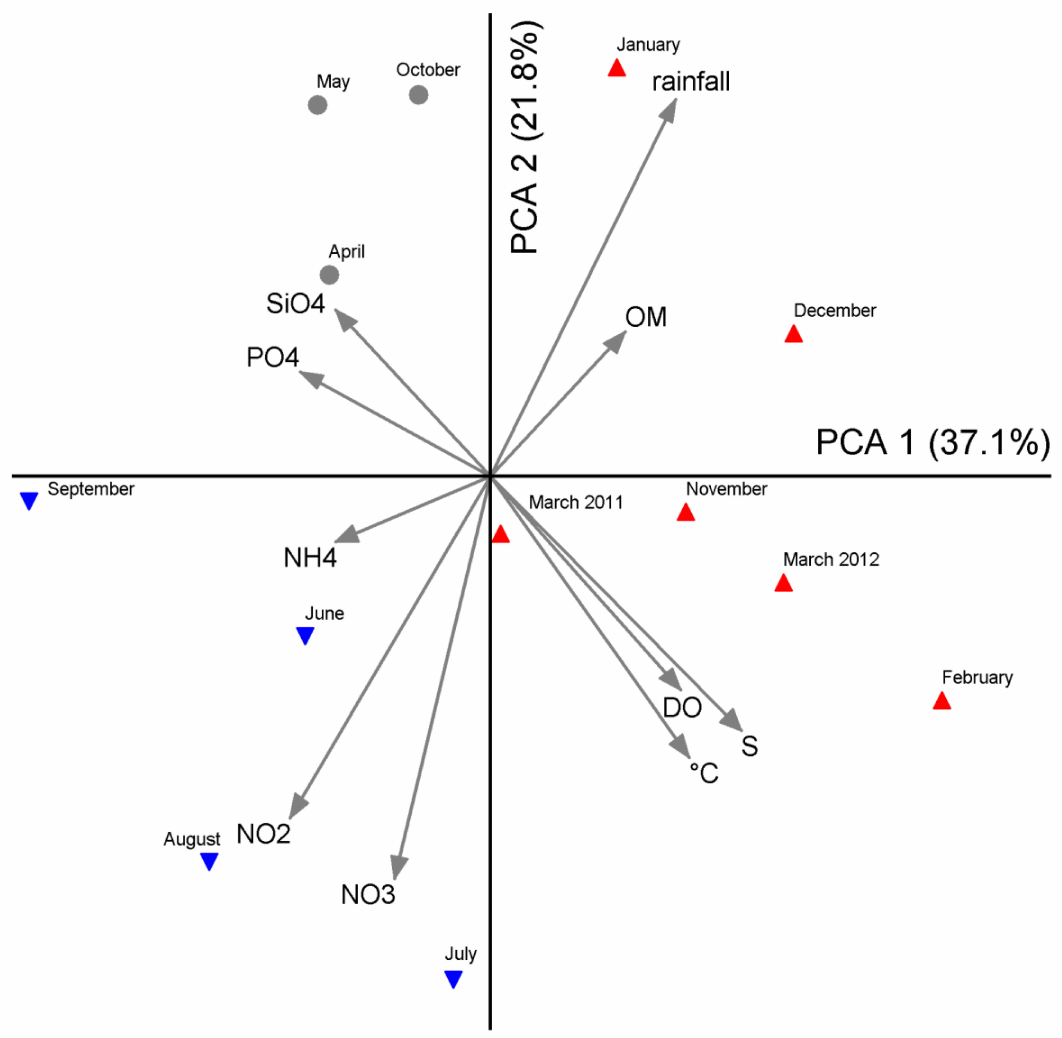
Figure 2. Biplot diagram of environmental variables collected during an annual cycle, from March 2011 to March 2012, in the estuarine region of Guanabara Bay. Environmental variables analyzed were accumulated rainfall (mm); salinity (S), temperature ( ◦ C), ammonium (NH 4 ), nitrate (NO 3 ), nitrite (NO 2 ), phosphate (PO 4 ), silicate (SiO 4 ), and dissolved oxygen (DO) in the bottom water; and organic matter in the sediment (OM). Distinct symbols and colors indicate that samples were collected in the warm-rainy ( (cid:78) ), intermediate ( • ), and cold-dry seasons ( (cid:72) ). Minimum, maximum, and mean values ( ± standard deviation) of environmental variables from different ecosystem compartments during the warm-rainy, intermediate, and cold-dry seasons are shown in Table 2. The lower values of bottom water temperature were found during the warm-rainy season (i.e., summer in southeastern Brazil), when salinity and dissolved oxygen in the bottom water varied from 30–37.2 and 3.56–5.19 mg L − 1 , respectively. The highest values of phosphate, nitrate and nitrite in bottom water were found in the late cold-dry season (September) and, just a month after, the highest value of ammonium was detected in the early intermediate season (October). The highest concentration of silicates was detected during the warm-rainy season (January), occurring simultaneously with low temperature (20–21 ◦ C) and high salinity (33.8–34.1) in bottom water. Higher amounts of organic matter in the sediment were found during the rainy season, when accumulated rainfall was higher than 100 mm month − 1 . The predominant sediment type was silt (muddy sand according to Folks’ textural classification), with